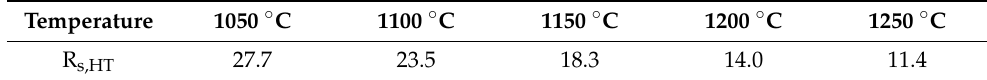
Figure 3. Weight loss curve of sinter during high-temperature reduction after pre-reduction. Table 3. High-temperature reduction degree of sinter, %.